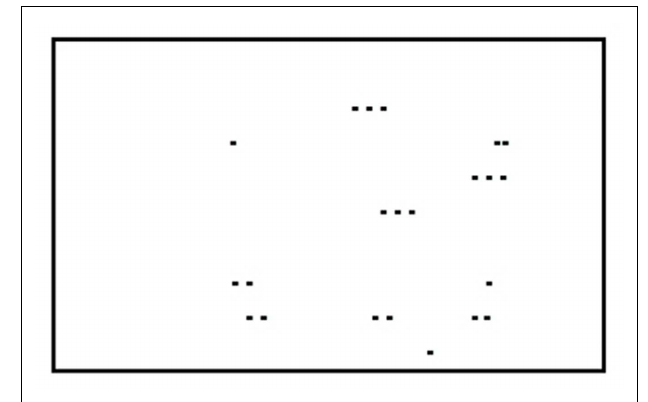
FIGURE 3 | Degraded